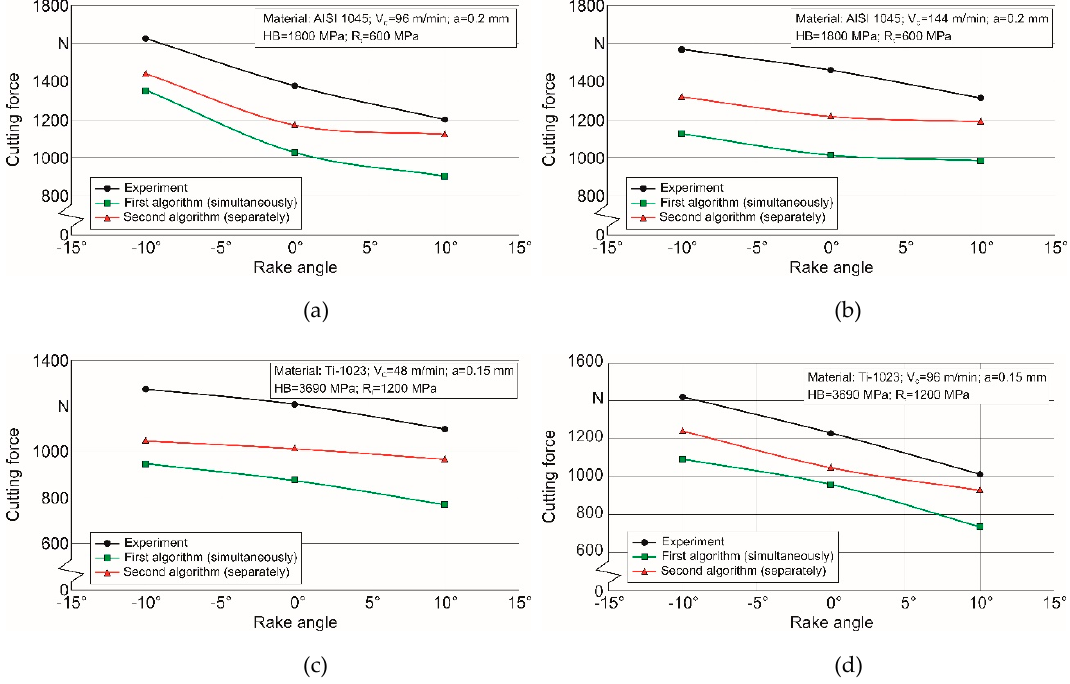
Figure 10. Dependence of the cutting force on the rake angle for different cutting speeds (( a )—experimental and simulative data when cutting steel AISI 1045 at 96 m/min, ( b )—the same by cutting speed 144 m/min, ( c )—experimental and simulative data when cutting titanium alloy Ti-1023 at the cutting speeds of 48 m/min, ( d )—the same by cutting speed 96 m/min).